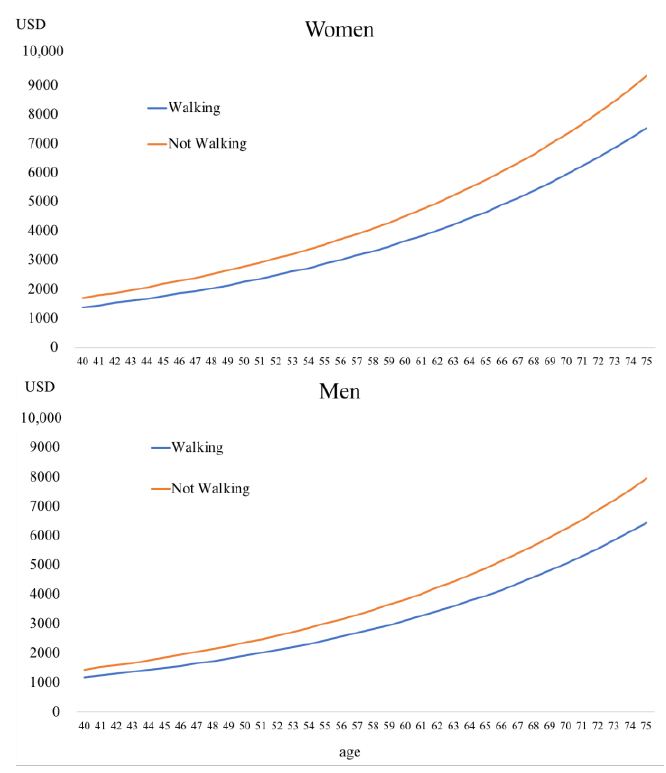
Figure 3. Five-year cumulative outpatient and medication expenditure for subjects without medication.